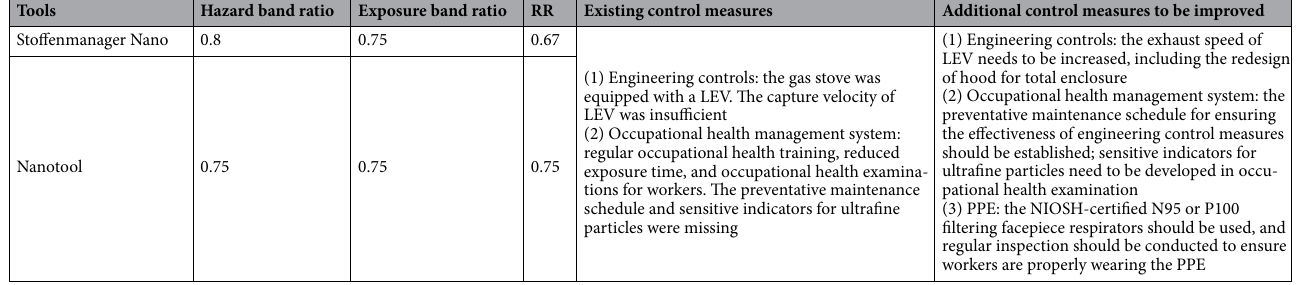
Table 5. The outcomes of risk assessment and